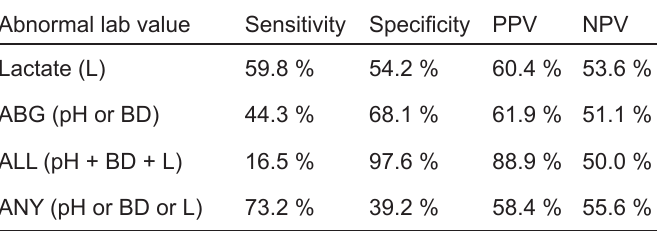
Table 6 . Abnormal laboratory values associated with hospital